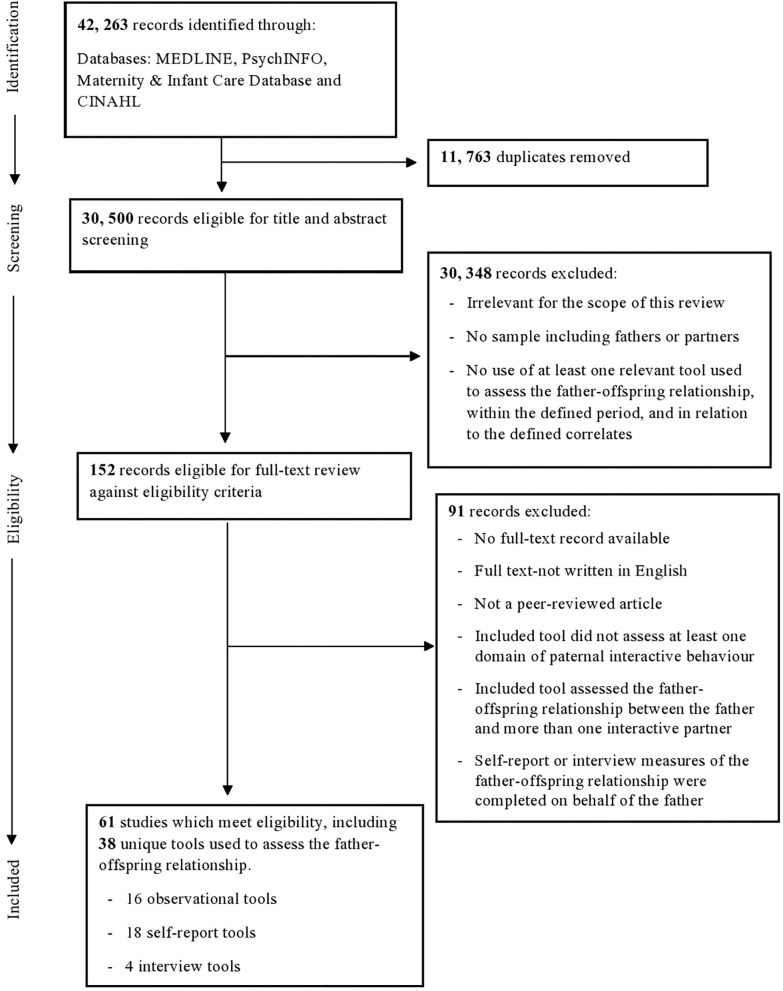
Flowchart of review process.